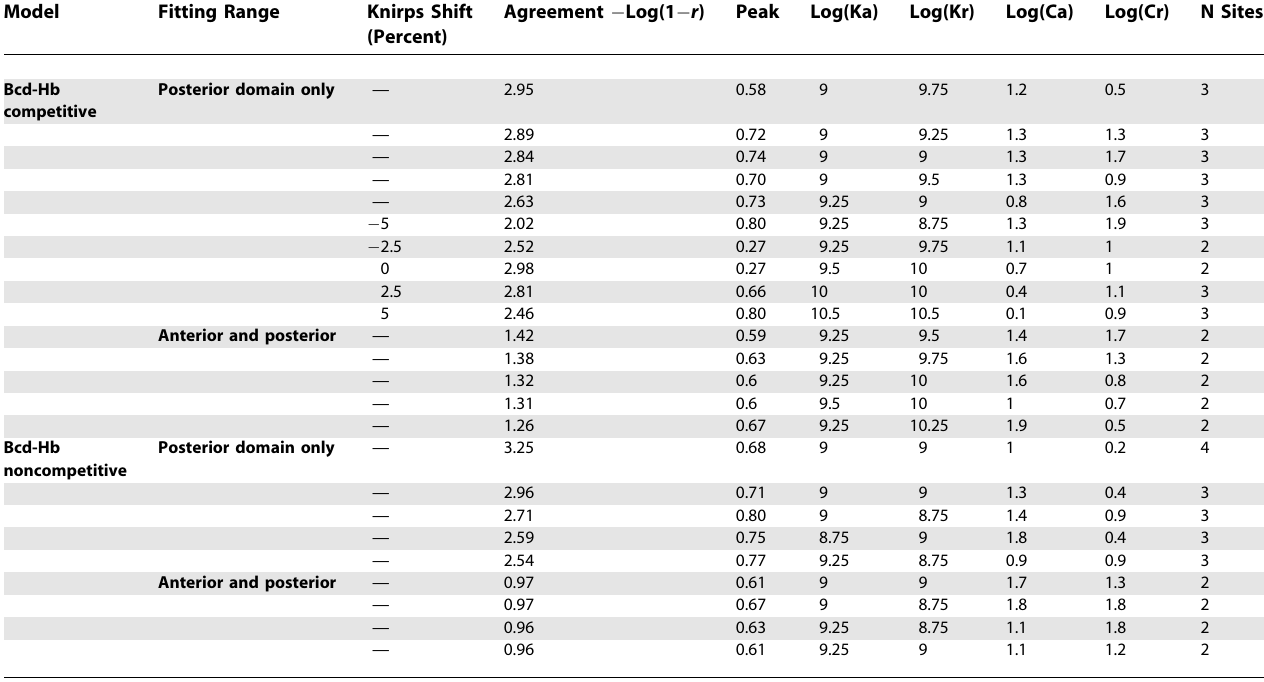
Table 1. Successful Parameter Combinations for knirps Model Fitting